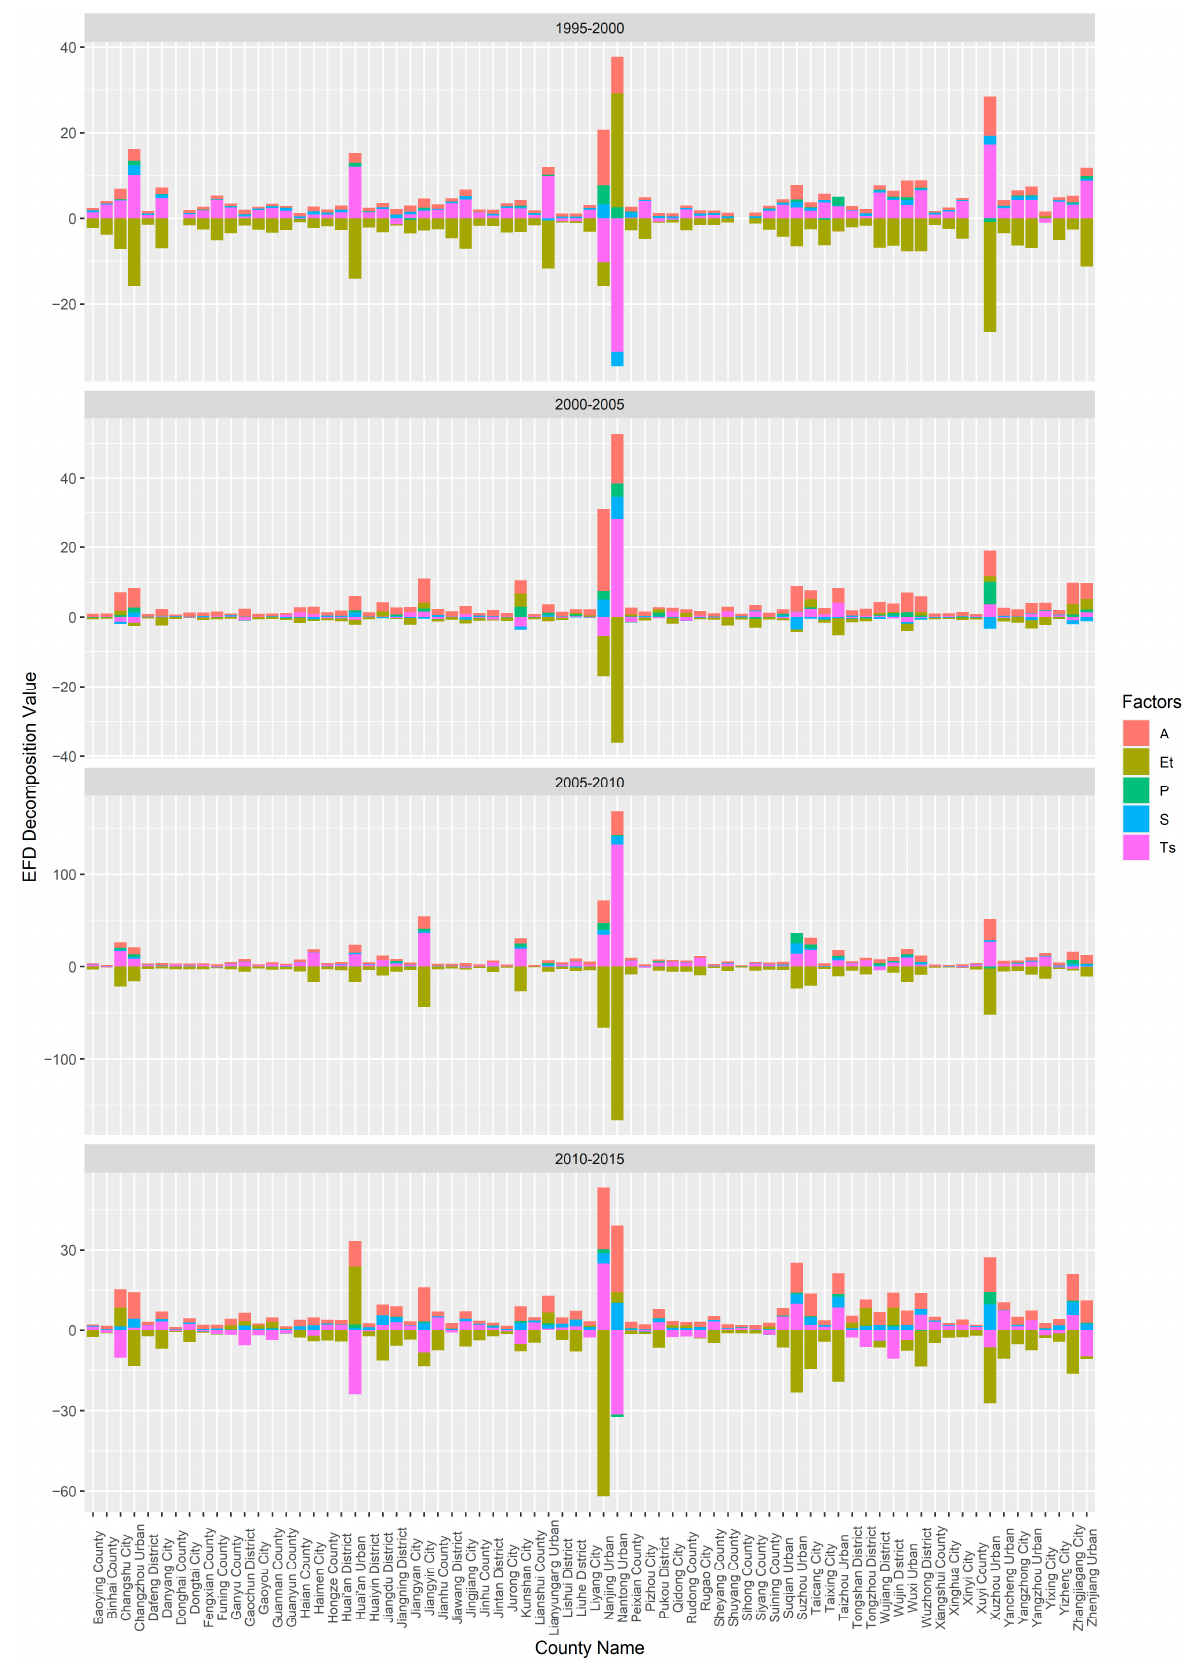
Figure 8. LMDI decomposition of the EFD changes in Jiangsu’s counties from 1995–2015.